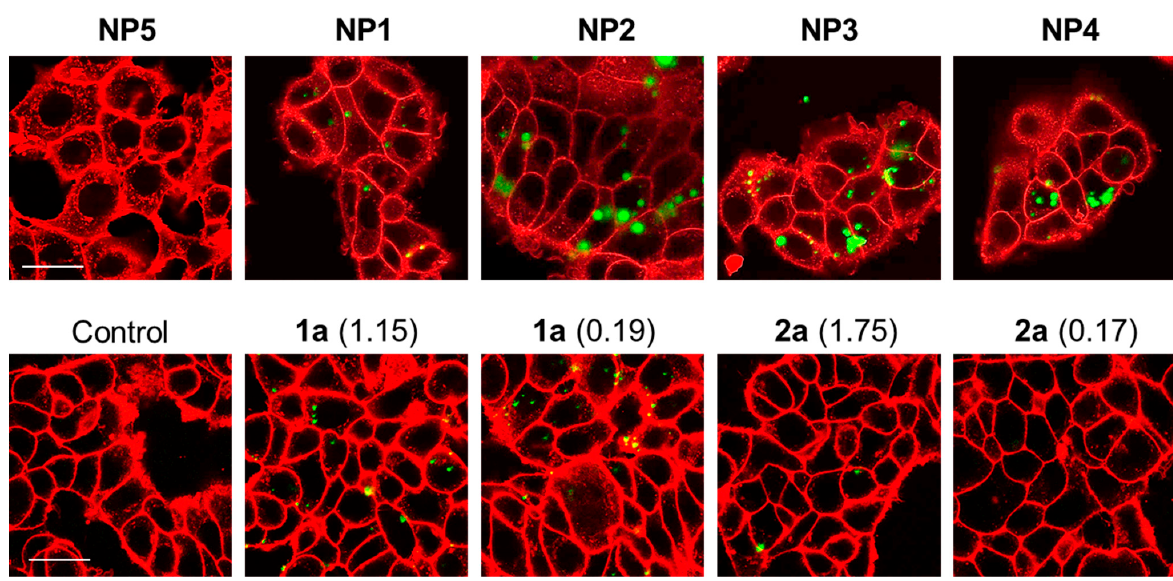
Figure 3. 2PEF imaging of MCF-7 breast cancer cells incubated for 20 h with NP1-5 (25 µg·mL − 1 ) and with analogous TEG-ylated 1a and 2a at the same porphyrin concentrations. Porphyrins were excited with Chameleon femtosecond laser (in green, λ ex = 790 nm) and cell membranes were stained with CellMask Orange (in red, λ ex = 561 nm). Scale bar: 10 µm.